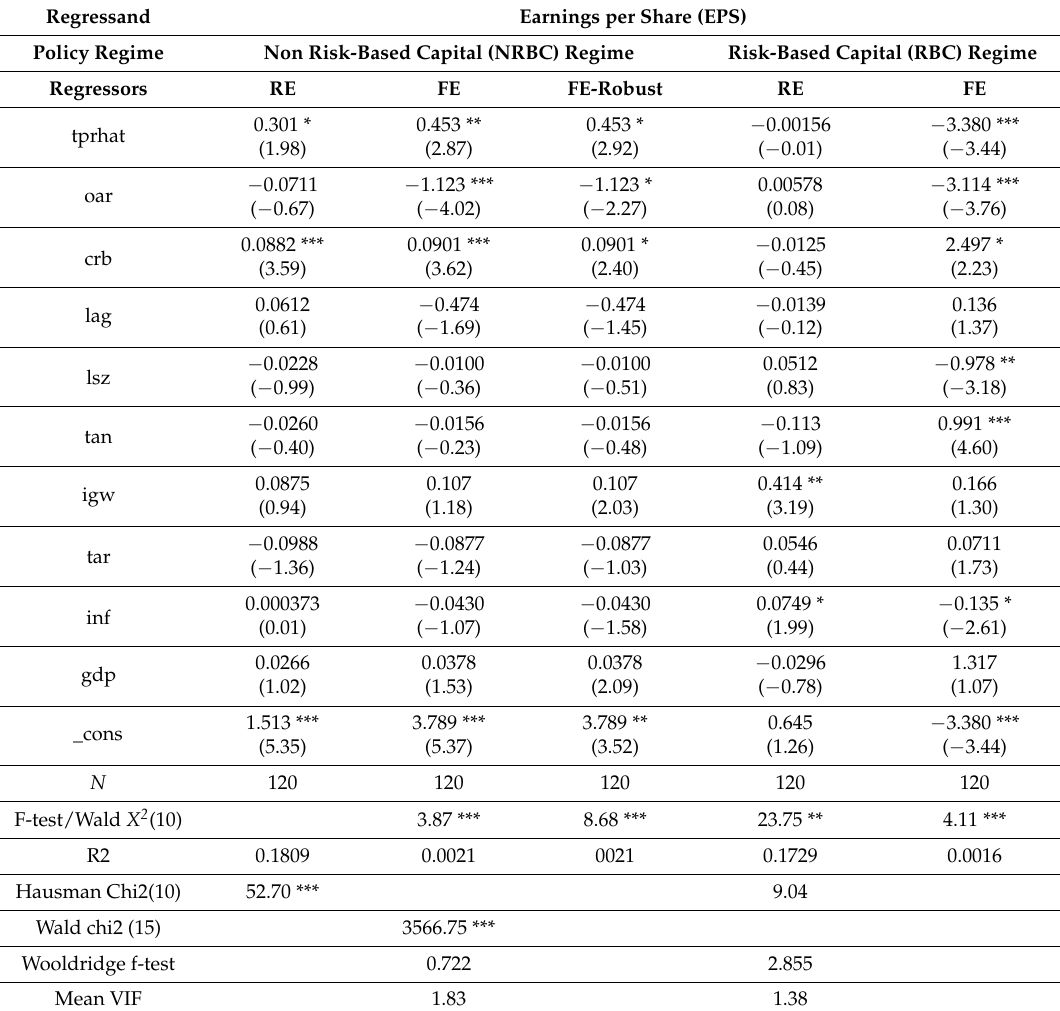
Table 6. TPR and EPS regression result for NRBC: 1995–2002 and RBC: